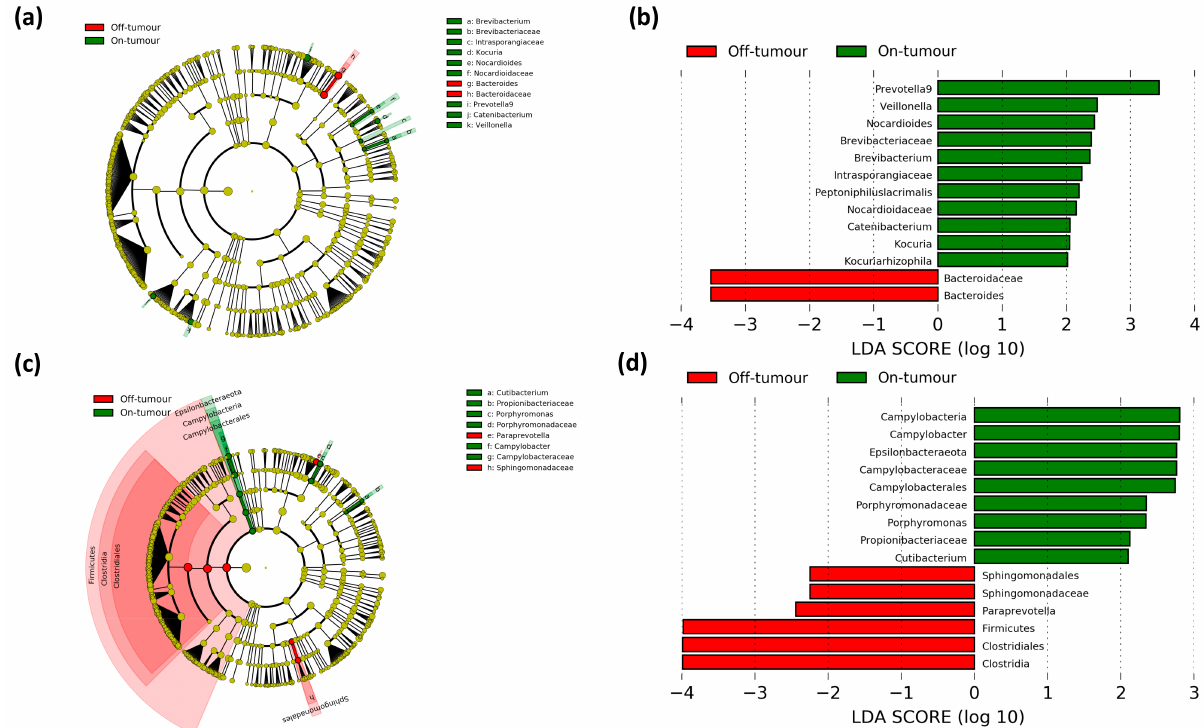
Figure 5. Paired comparison of on- and off-tumor taxa between treatment groups. LEfSe cladogram and histogram of LDA scores for differentially abundant bacterial taxa between on- and off-tumor microbiota in oral ( a , b ) and intravenous ( c , d ) iron-treated patients. Taxa and nodes highlighted in red were more significant in the off-tumor microbiota and green in the on-tumor microbiota. Taxa with an LDA score greater than 2 with a p -value ≤ 0.05 were considered statistically